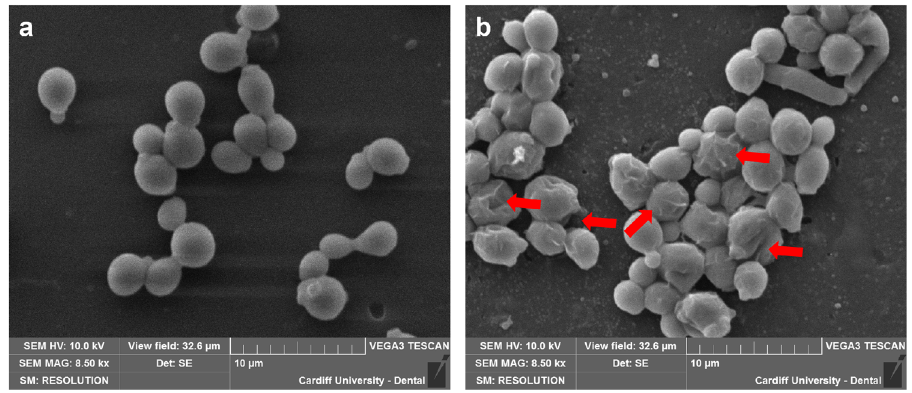
Figure 6: Morphological assessment of C. albicans : ( a ) control and ( b ) AgNPs treated and their e ff ect on the fungal structure ( marked in red arrows ) .